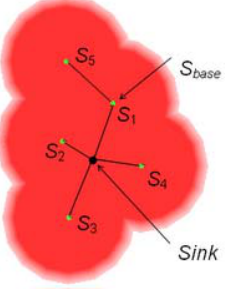
Figure 7. An example of base node